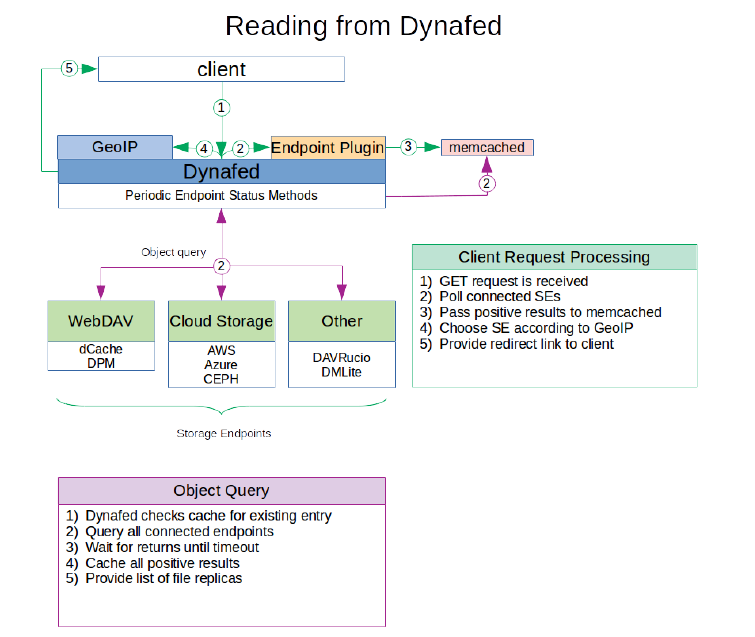
Figure 1: Flow chart of a read request send to